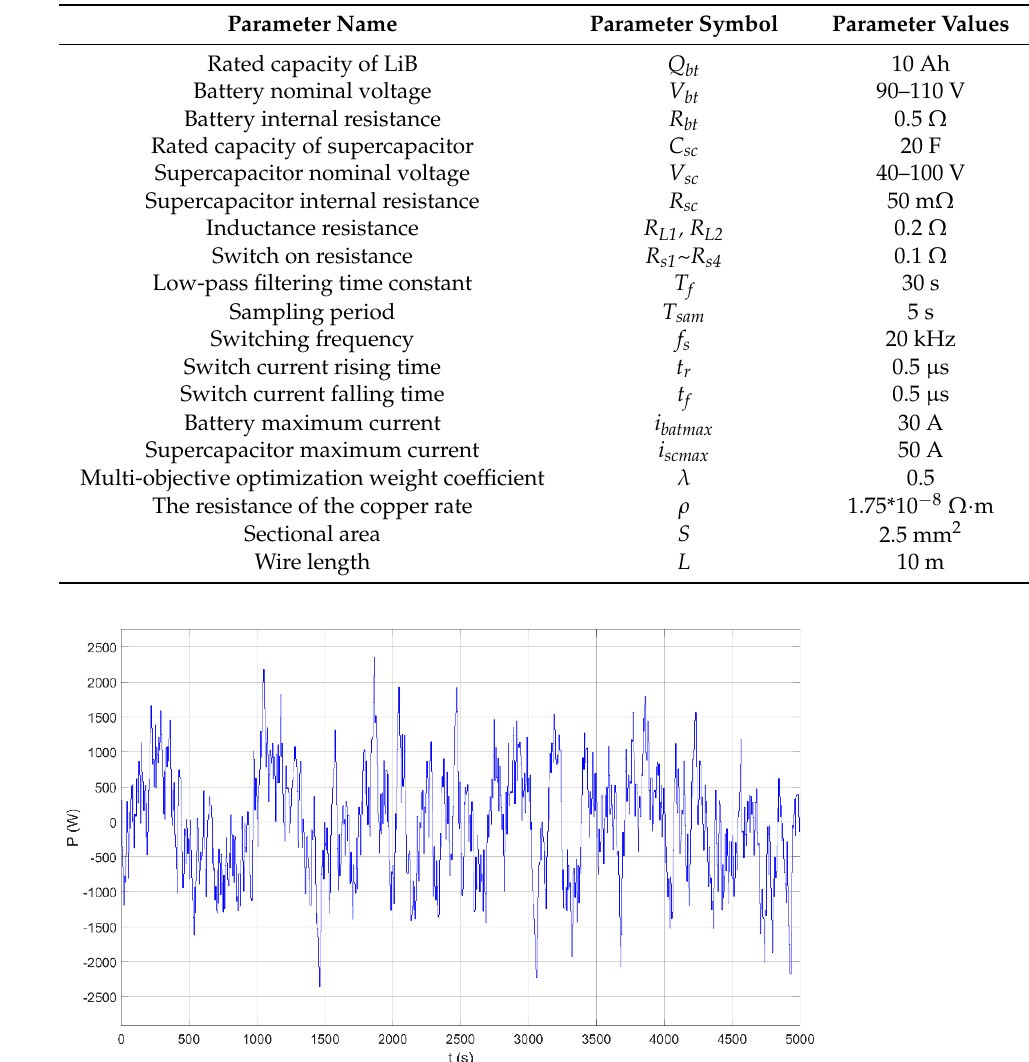
Table 1. HESS parameters.